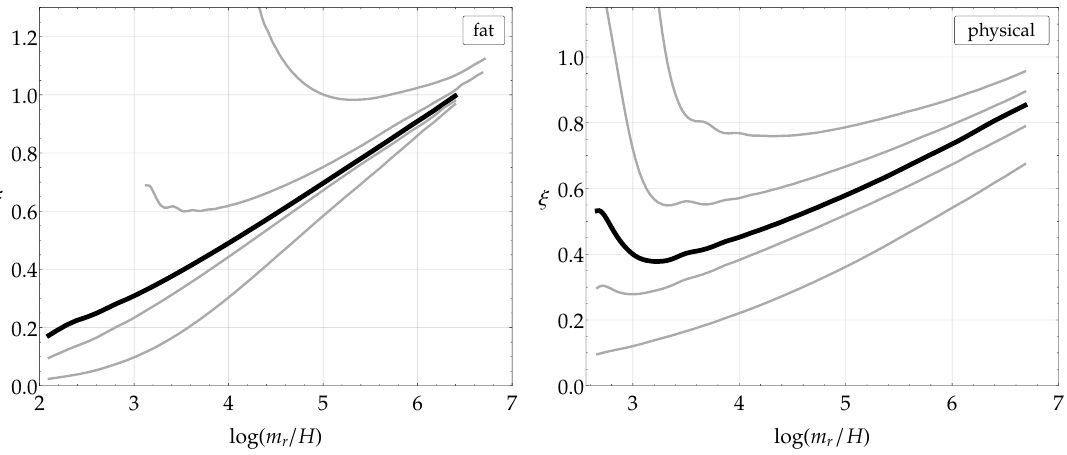
Figure 3 . The growth of (cid:24) ( t ) with time (log( m r =H )) for di(cid:11)erent initial conditions using the fat string trick (left) and in the physical case (right). The black curves correspond to the initial conditions that are the closest to the attractor